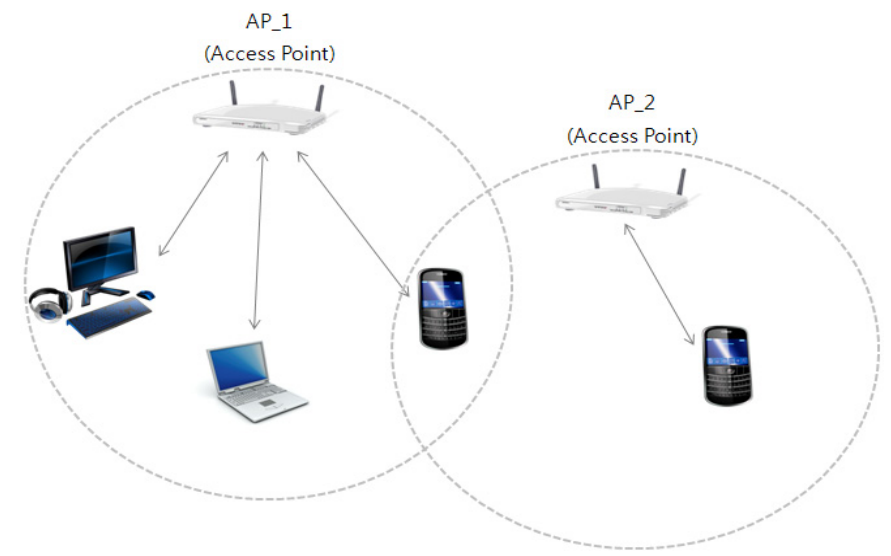
Figure 7. AP as central unit in All-Wireless